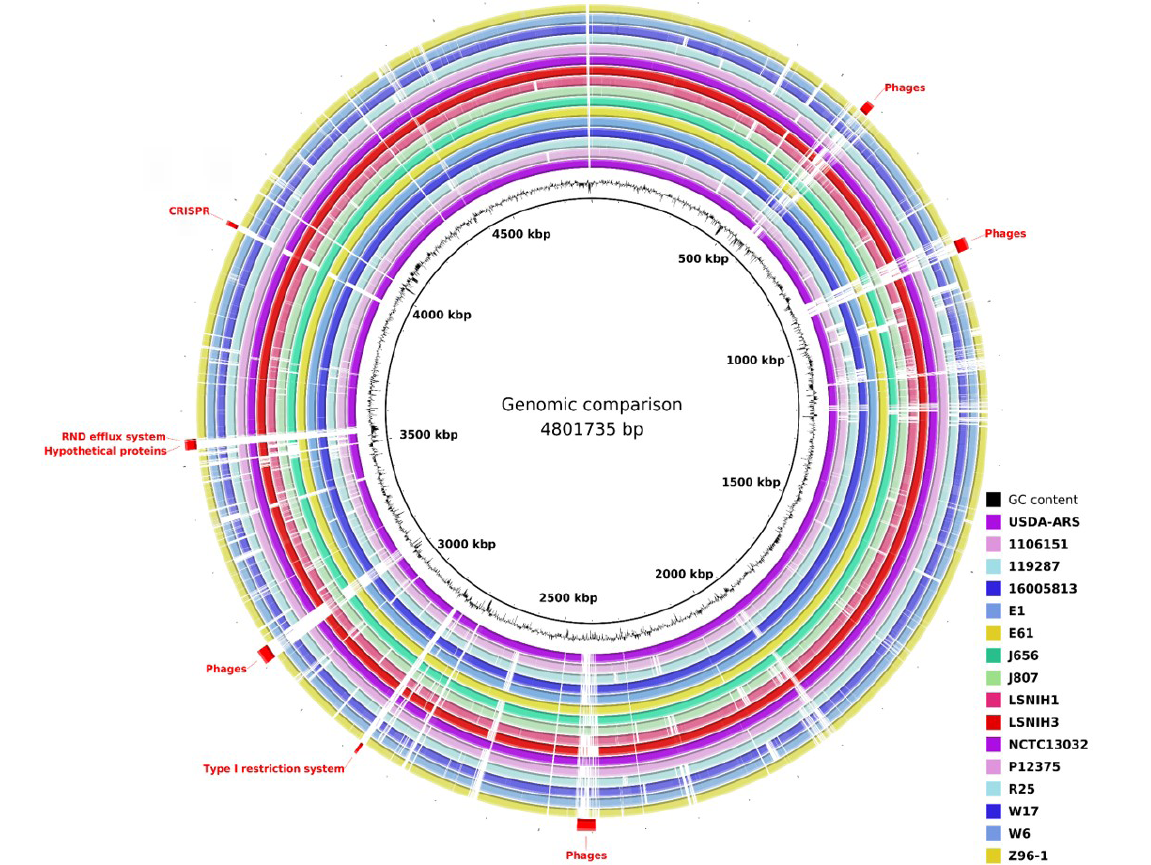
Figure 1 – Genomic comparison among Leclercia strains. Each ring represents the genome of one strain. Leclercia adecarboxylata strain Palotina (NCBI BioSample SAMN09791487) was used as genome of reference. Gaps in the rings mean absence of the region in the target